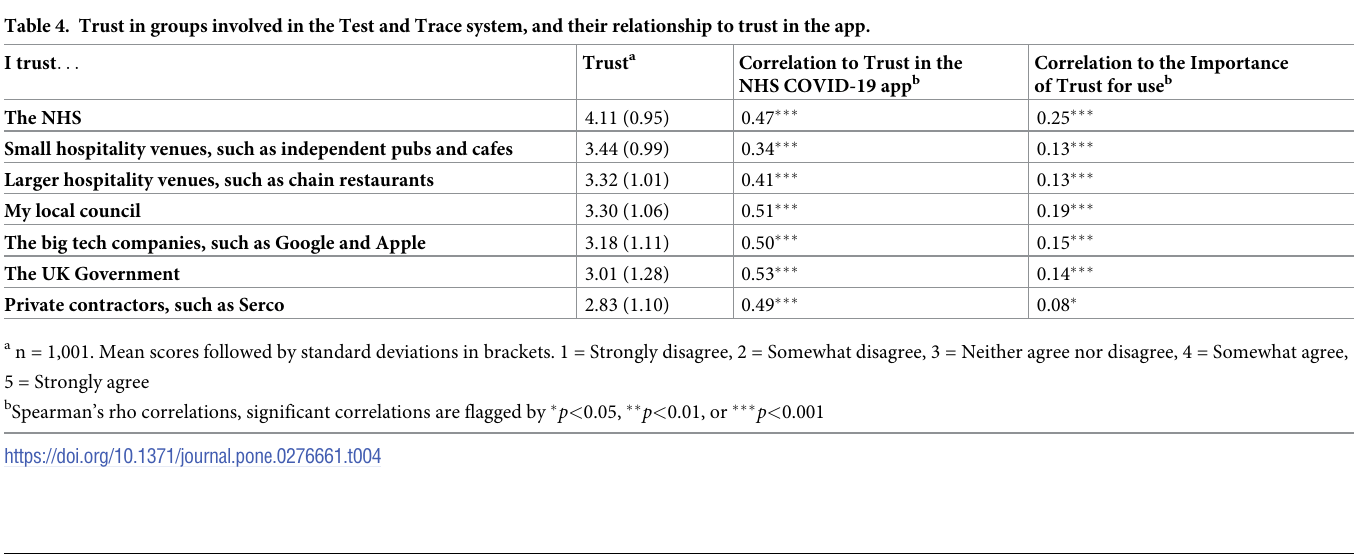
Correlation to the Importance NHS COVID-19 app b of Trust for use